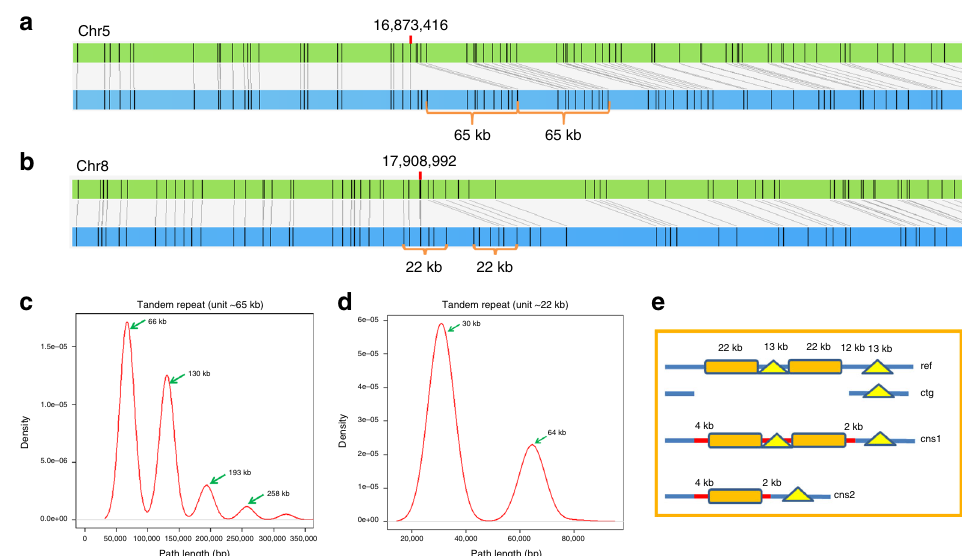
Fig. 2 An illustration of identifying tandemly repetitive sequences by HERA. a A tandemly repetitive sequence on chromosome 5 of R498 with a unit length of 65 kb. The upper green horizontal bar represents the assembled sequence lacking a unit and the lower blue bar represents the BioNano map. b A repetitive sequence on chromosome 8 of R498 with a unit length of 22 kb. c The length distribution of HERA generated tiling paths for the repeat shown in ( a ). The paths are divided into several clusters and the distances between adjacent peaks are 65 kb which matched the repeat unit length in ( a ). The second peak represents the whole region of two repeat units (130 kb). d The length distribution of HERA generated tiling paths for the repeat in ( b ). The paths are divided into two clusters and the distance between the two peaks is around 35 kb. e The schematic representation of the repeat region in ( b ). In this region, there are two highly similar repeat units of 22 kb (rectangle) being separated by one of the two dissimilar repeat units of 13 kb (triangle). Ref, the full repeat region; ctg, the fl anking sequences to be connected; cns1 and cns2, excluding the fl anking sequences shown in ctg, correspond to the second and the fi rst peak in ( d ),